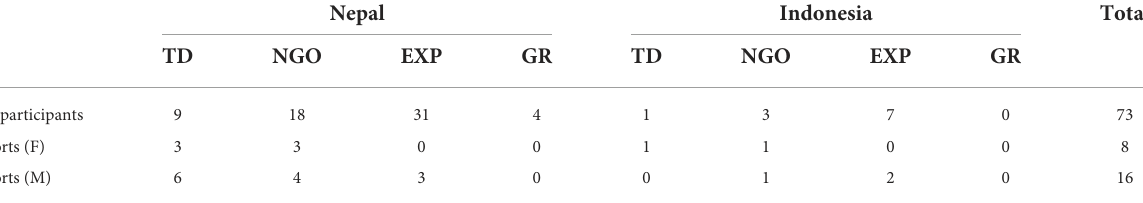
TABLE 4 Characteristics of sampled NF